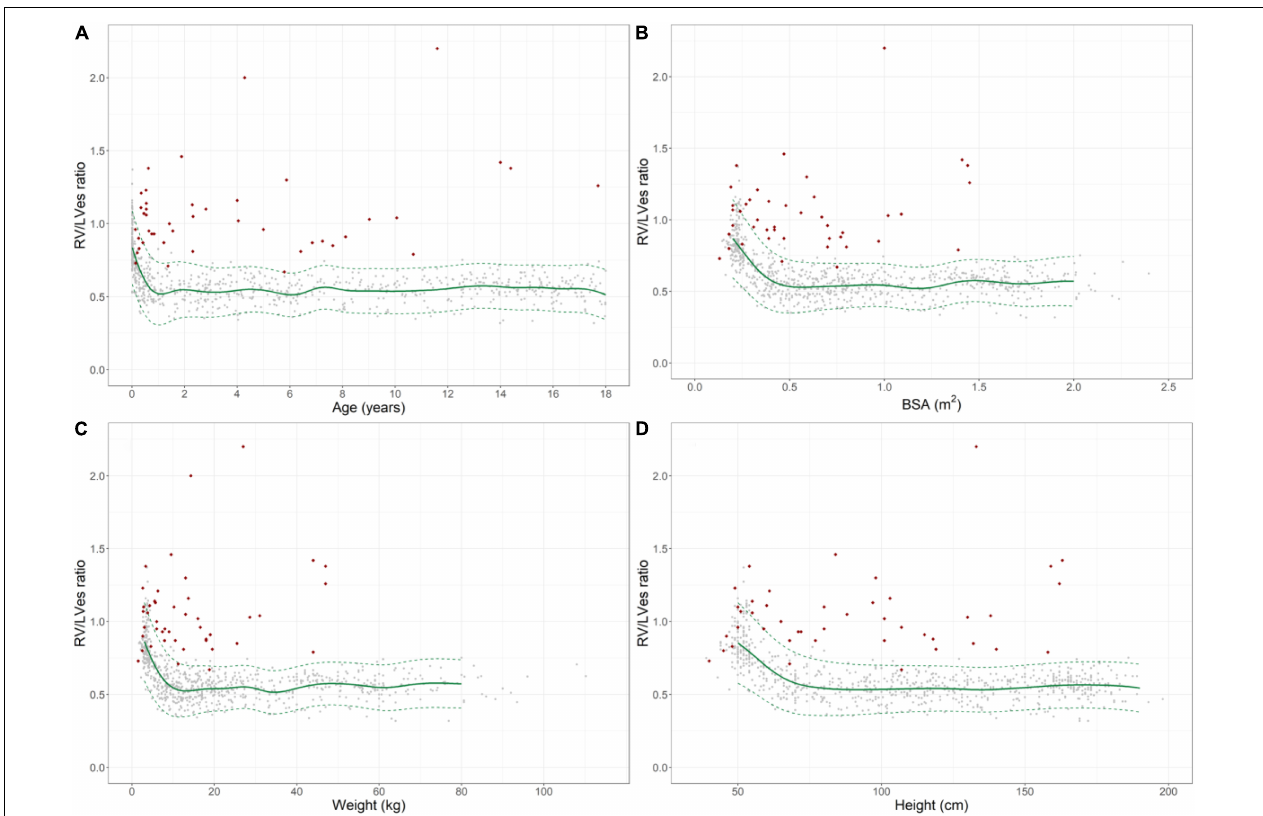
FIGURE 2 | Normal reference values for right ventricular to left ventricular endsystolic (RV/LVes) ratio in healthy children and individual levels of pulmonary hypertension patients (red diamonds). Normal change of RV/LVes ratio with increasing (A) age, (B) BSA, (C) weight and (D) height (gray circles: individual values; green solid line: median, dashed green line: 2.5 and 97.5%